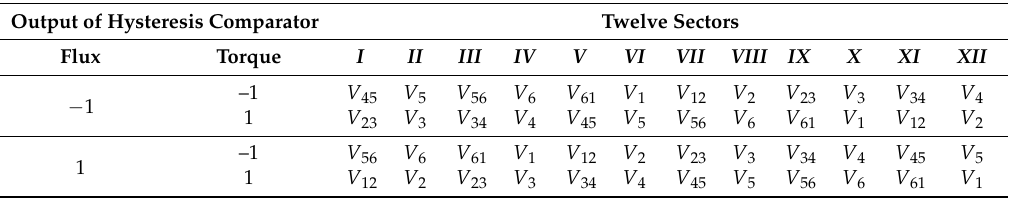
Table 3. Twelve sectors voltage vector switch table (motoring mode).